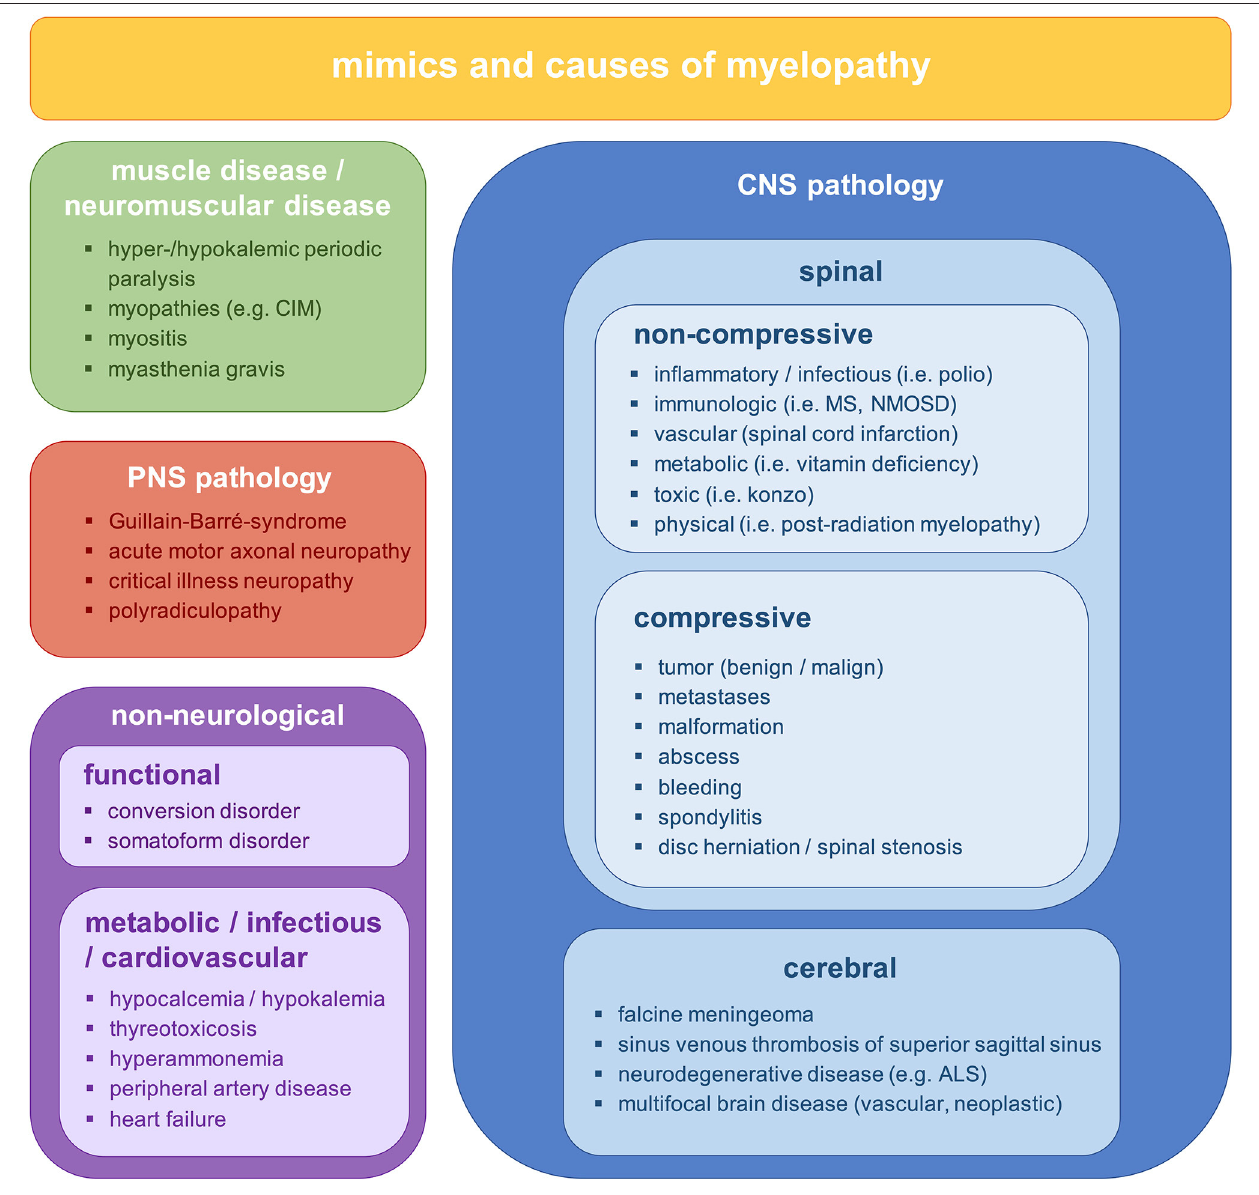
FIGURE 1 | Differential diagnoses of bilateral sensorimotor deficits. ALS, amyotrophic lateral sclerosis; CIM, critical illness myopathy; CNS, central nervous system; MS, multiple sclerosis; NMOSD, neuromyelitis optica spectrum disorder; PNS, peripheral nervous